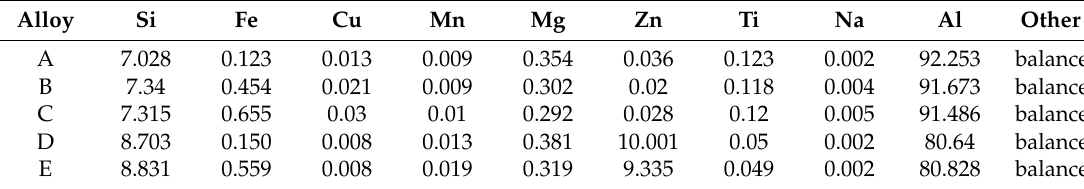
Table 1. Chemical composition measured using arc spark spectroscopy, wt.